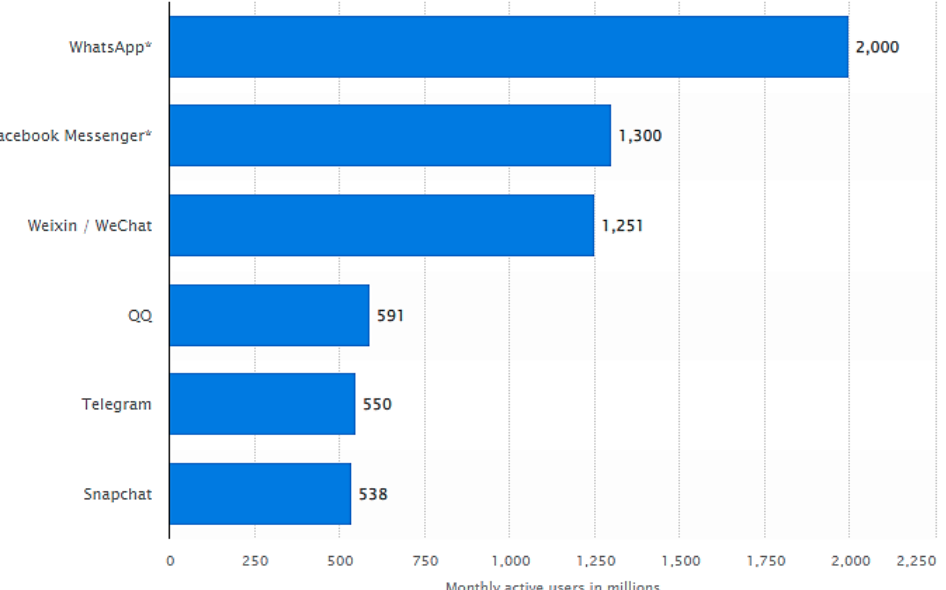
Figure 1. WhatsApp monthly active users compared to other IM